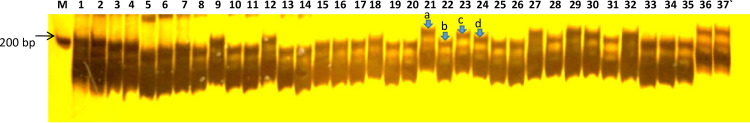
PAGE profile of SSR marker ‘HT-160b’ on 37 wheat genotypes showing length polymorphism.M = 100 base pair ladder, 1–26; heat tolerant wheat genotypes, and 27–37; heat susceptible wheat genotypes. The arrow shows four alleles—a, b, c, and d (marked on genotypes 21–24) amplified by HT-160b.